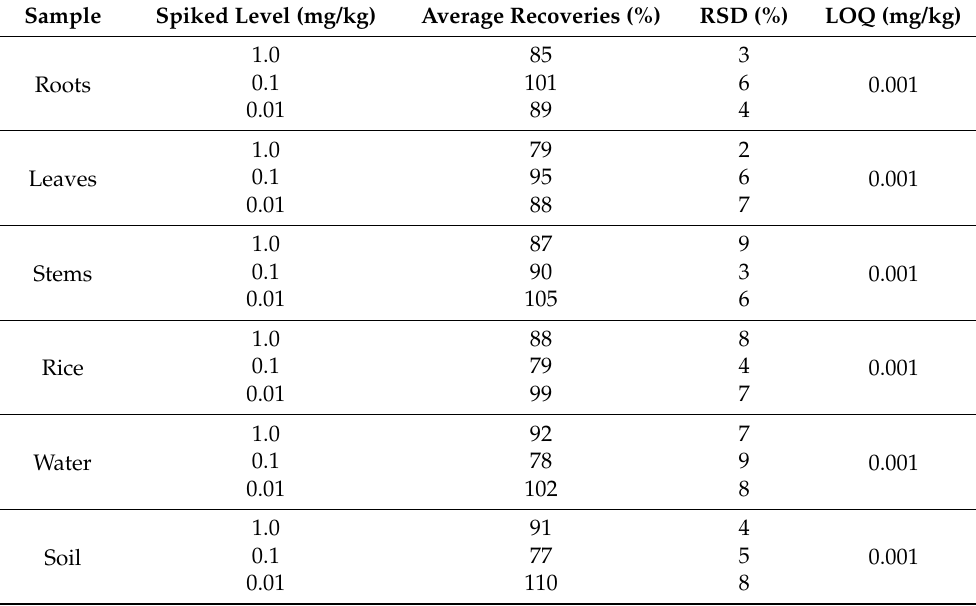
Table 3. Accuracy and precision of the analysis method in different matrices at three levels of spiked